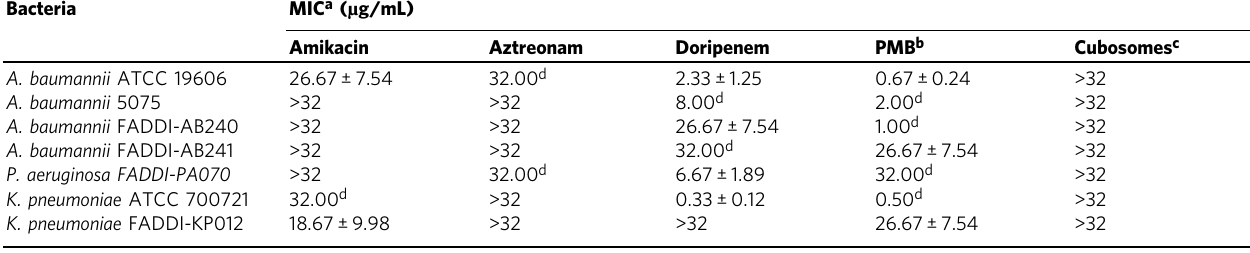
Table 1 Antimicrobial activity of antibiotics and cubosomes against isolates of A. baumannii , P. aeruginosa , and K. pneumoniae in